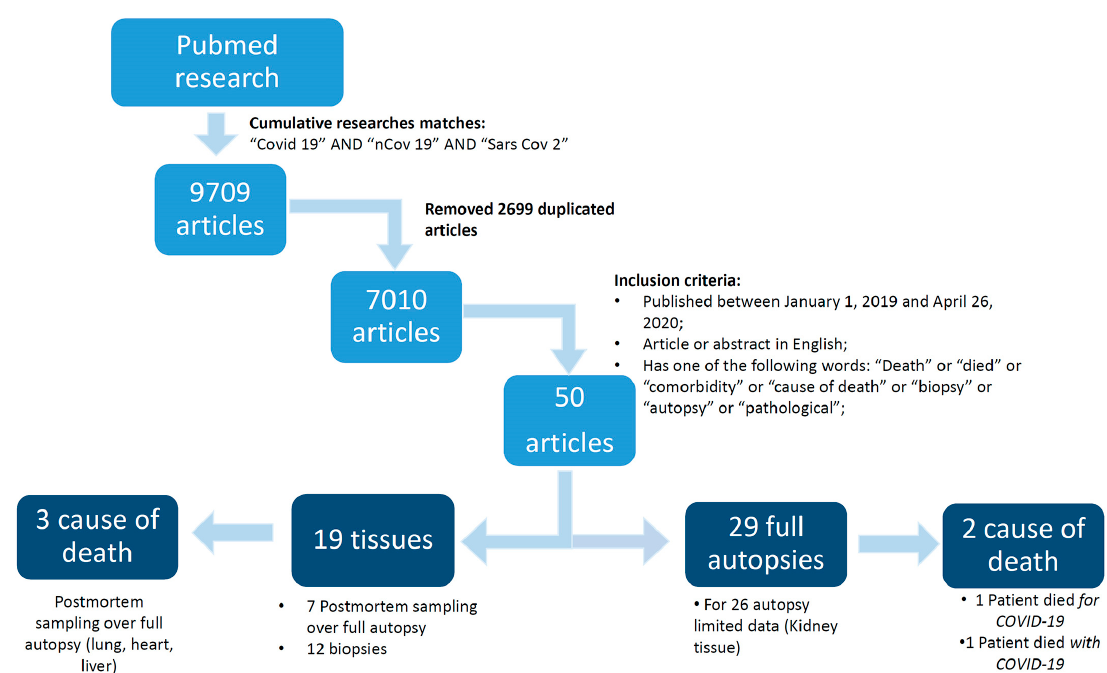
Figure 1. The search strategy used for literature review.